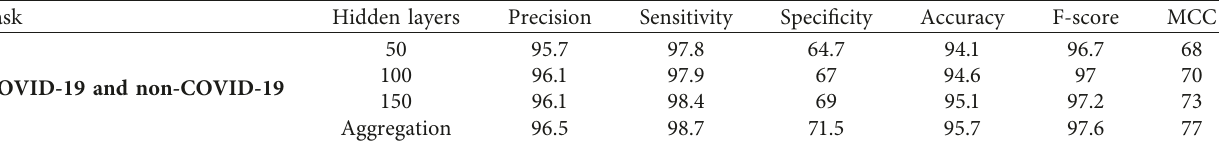
Table 6: Evaluation metrics for ELM.